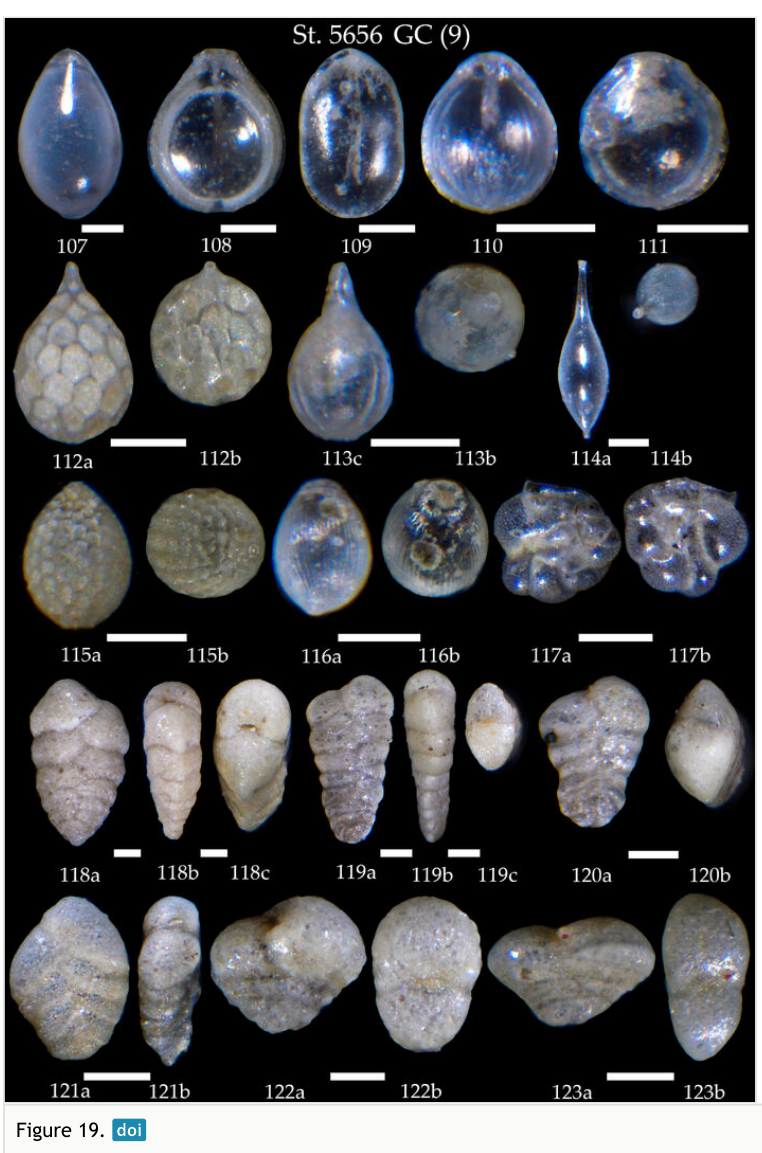
Figure 19. Station 5656GC (continued). 107-111 Fissurina sp.; 112,113 Lagena sp., a side view, b apertural view; 114 Procerolagena clavata , a side view, b apertural view; 115,116 Oolina sp. a side view, b apertural view; 117 Sp. cf. Asterorotalia pulchella , a, b side view; 118 Textularia sagittula , a, b side view, c apertural view; 119,120 Spiroplectinella wright , 119a, b side view, 119c apertural view, 120a side view, 120b apertural view; 121 Siphotextularia concava , a, b side view, b apertural view; 122,123 Sahulia conica , a side view, b apertural view. Scale 100